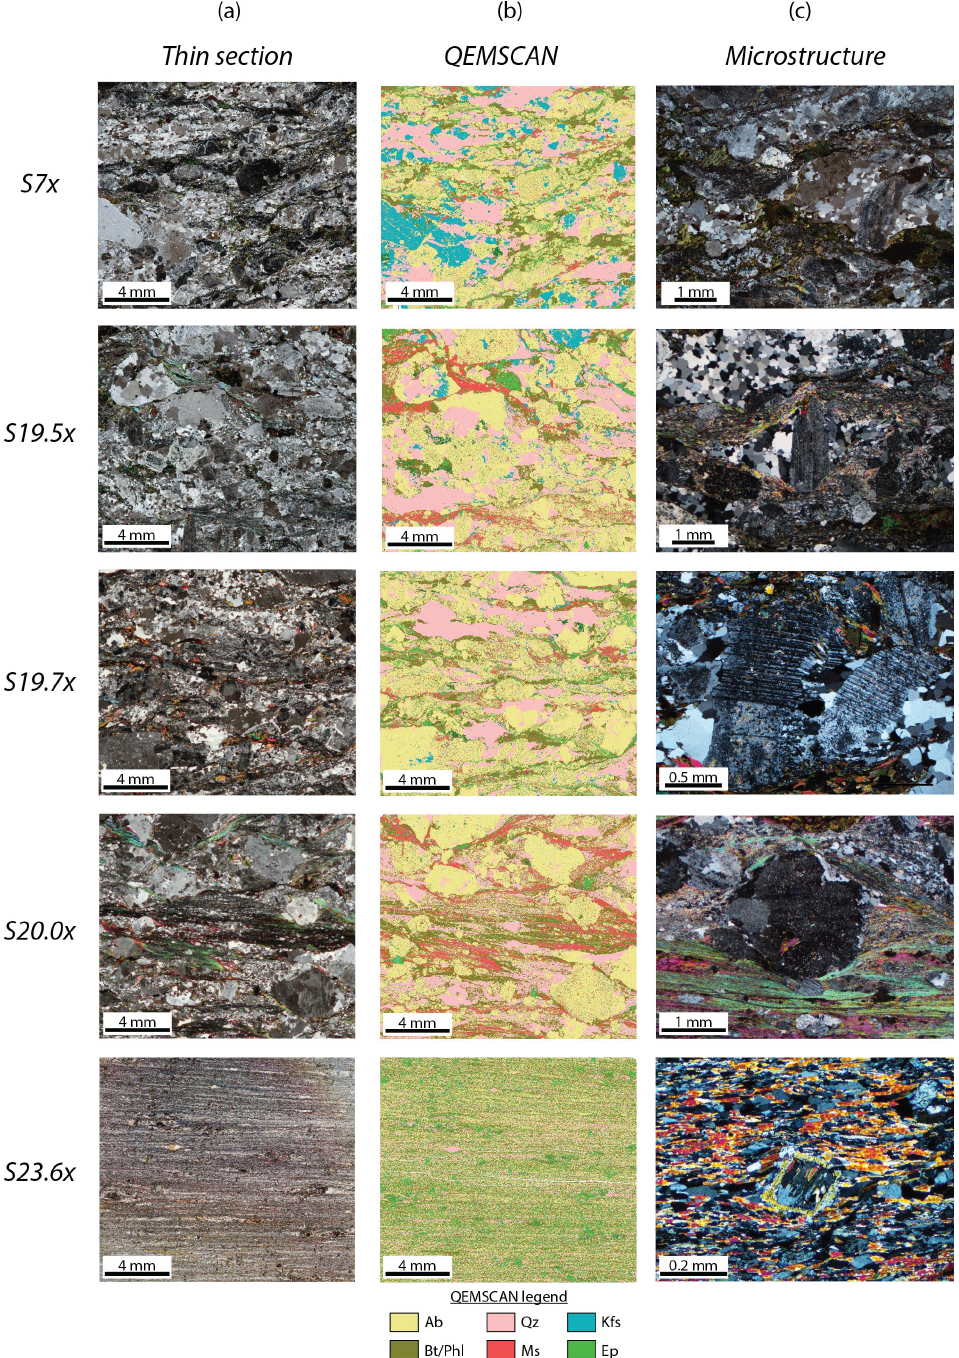
Figure 2. Optical microscopy and QEMSCAN ® images of thin sections for each x 1 sample (S7x, S19.5x, S19.7x, S20.0x, and S23.6x). Panel (a) shows the cross-polarized light image of the sample with the corresponding QEMSCAN ® area in (b) . Panel (c) depicts a particular microstructure of the sample. S7x – typical host rock texture with twinned feldspar and quartz. S19.5x – elongated feldspar with quartz in strain shadows between fine-grained mica. S19.7x – fractured feldspar with quartz grains filling the fracture. S20.0x – rounded sericitic feldspar clast with fine-grained quartz and mica infilling the strain shadows between lenses of large mica grains and fine recrystallized quartz/mica. S23.6x – very fine-grained foliated biotite and quartz grains surrounding euhedral plagioclase. Sample locations depicted in Fig. 1.